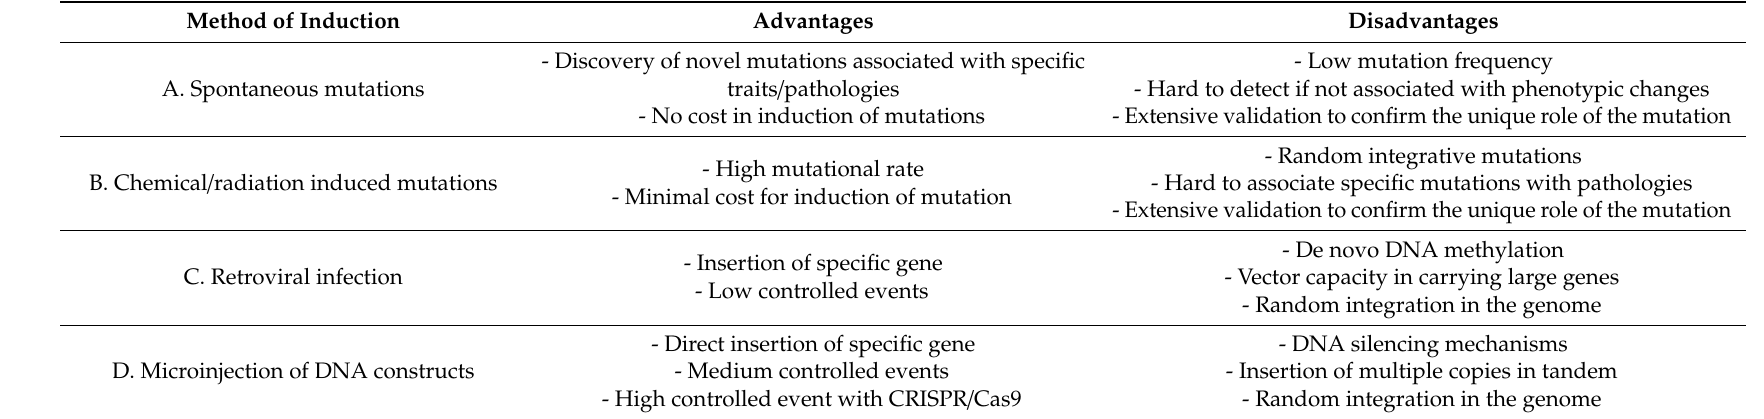
Table 2. Advantages and disadvantages of the widely used methods for generation of transgenic mice correspondent to Figure